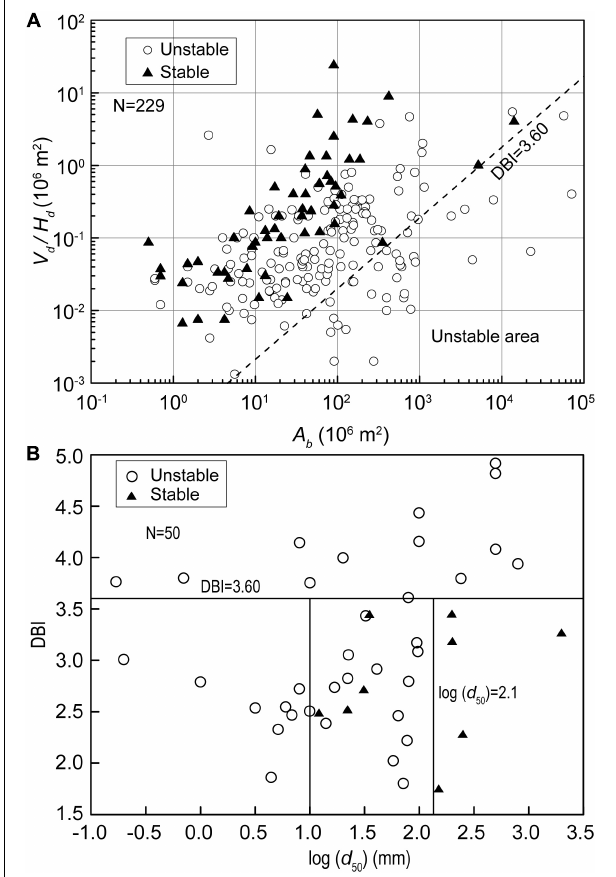
FIGURE 7 | Stability evaluation of landslide dams: (A) DBI (229 cases) and (B) d 50 (50